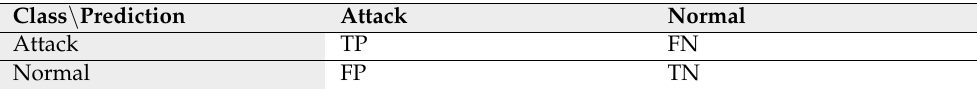
Table 4. Confusion matrix for anomaly traffic